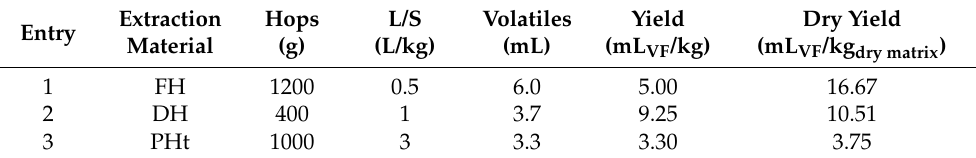
Table 3. MAHD, SOP protocol screening.